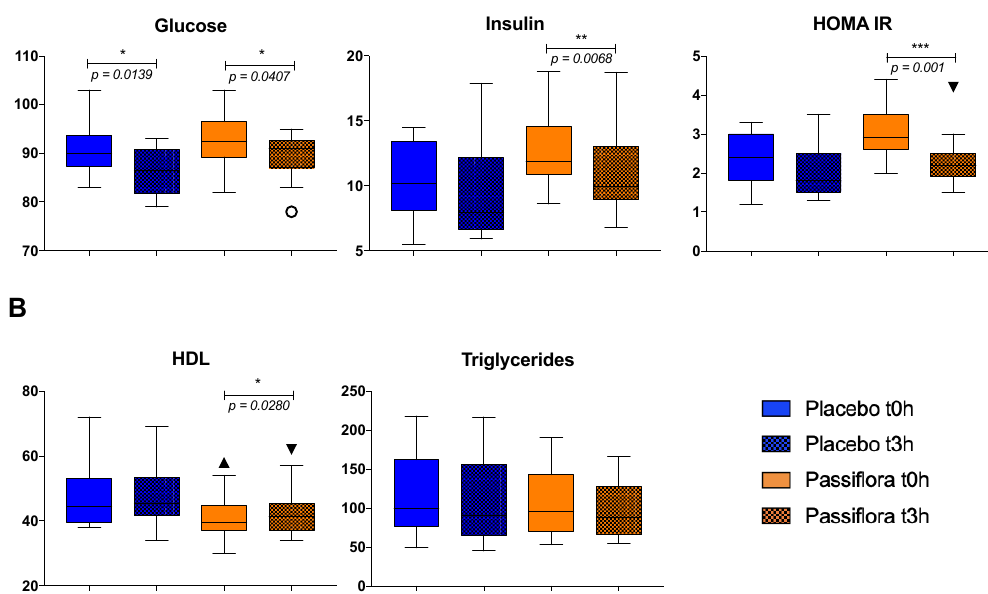
Figure 1. Acute effect of Passiflora setacea juice and placebo drink consumption on glucose ( A ) and lipid ( B ) metabolism markers in overweight volunteers ( n = 12). Results analyzed by means of the non-parametric paired t -test (Wilcoxon’s test), medians, and SD. * p ≤ 0.05, ** p ≤ 0.01, *** p ≤ 0.001.